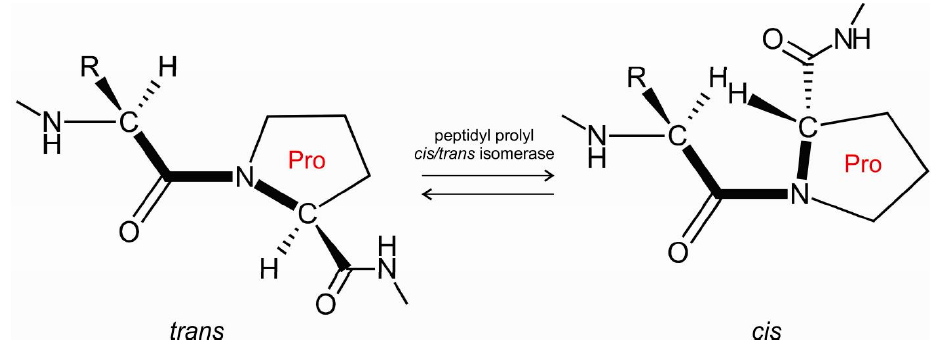
Figure 1. Peptidyl-prolyl cis / trans isomerase facilitates cis / trans isomerization of the X-Pro peptide